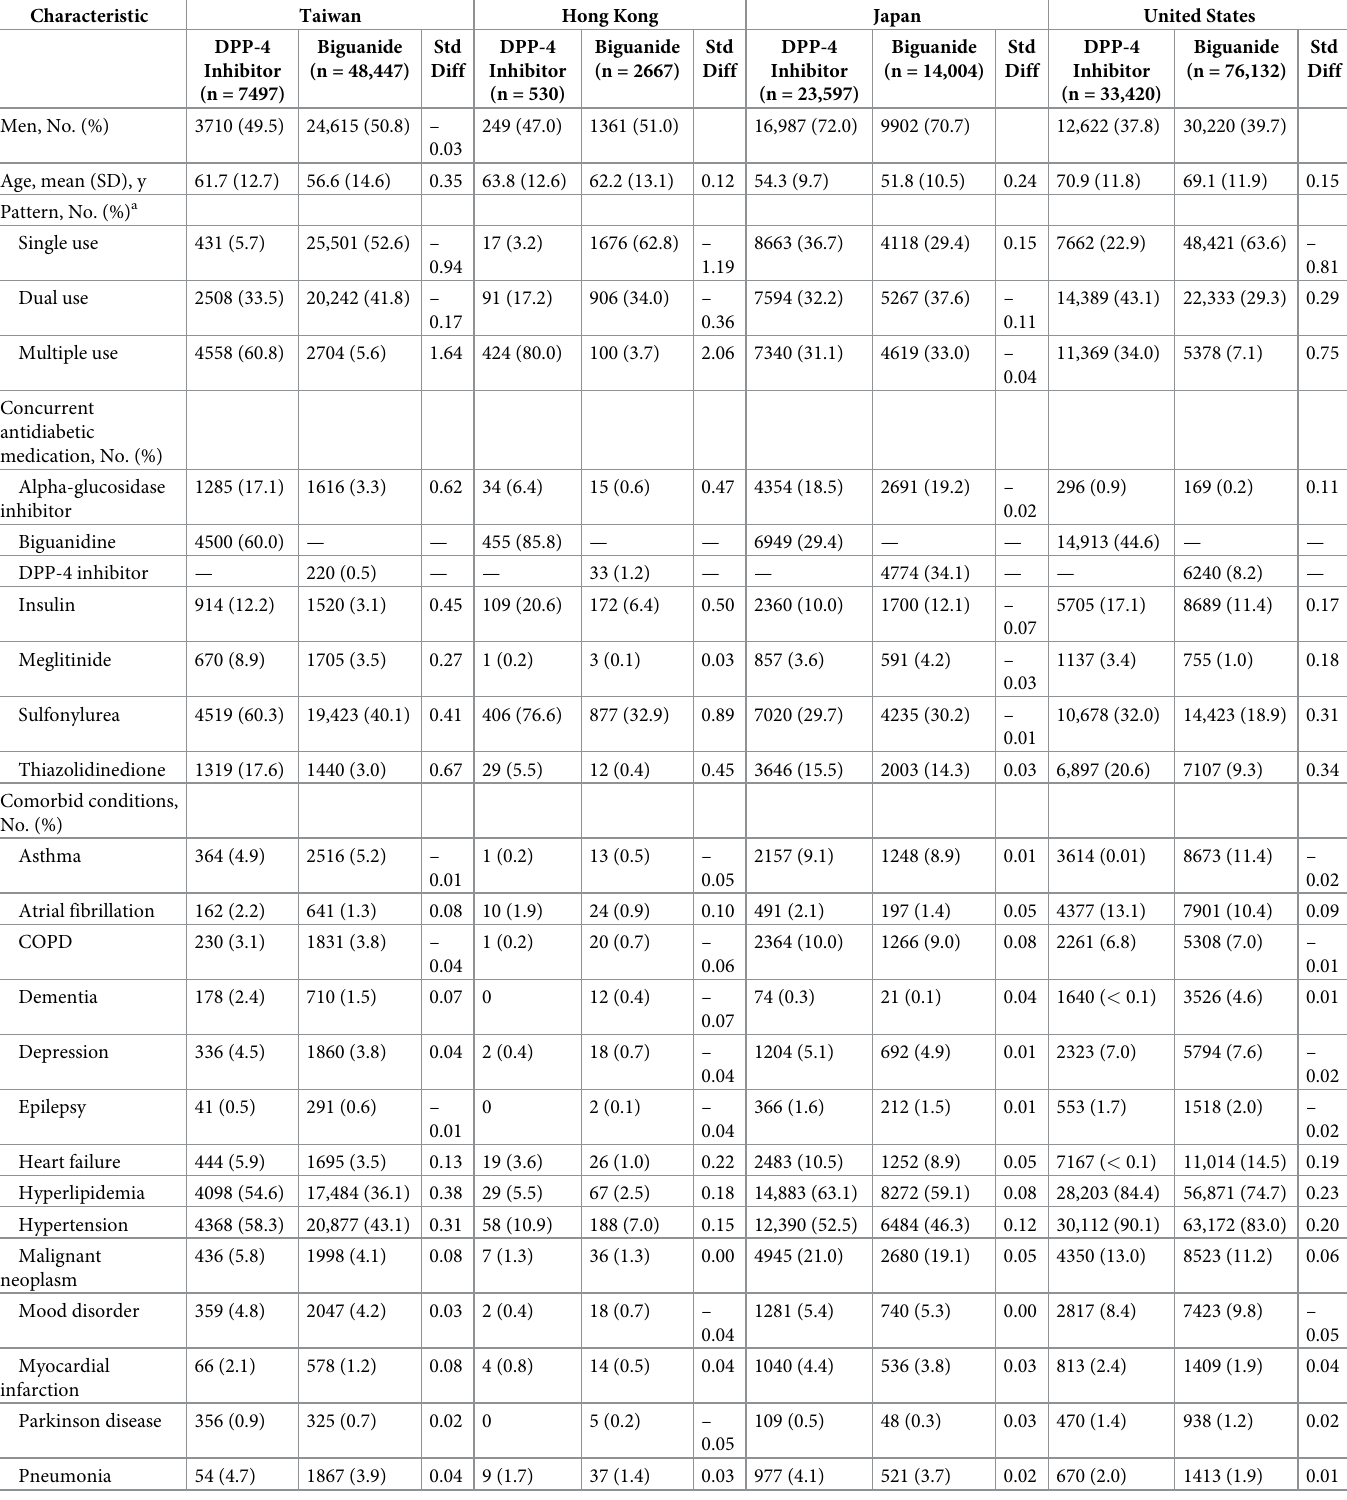
Table 2. Characteristics of new users of dipeptidyl peptidase-4 inhibitors and biguanides.